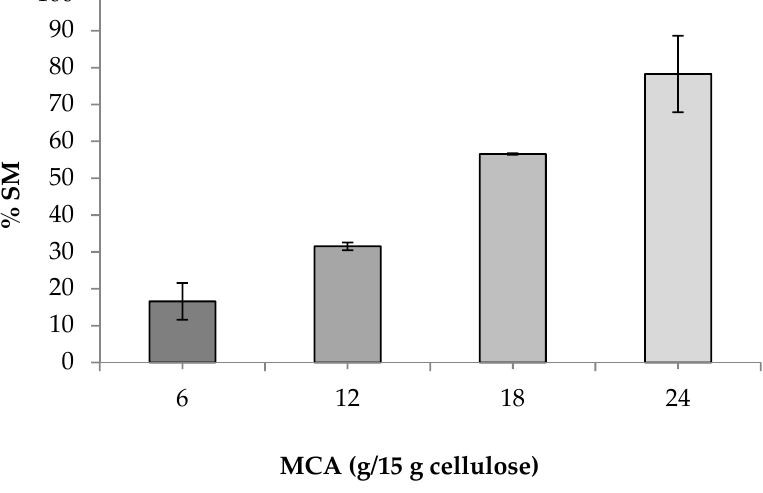
Figure 3. Effects of MCA levels on solubility of CMC n .